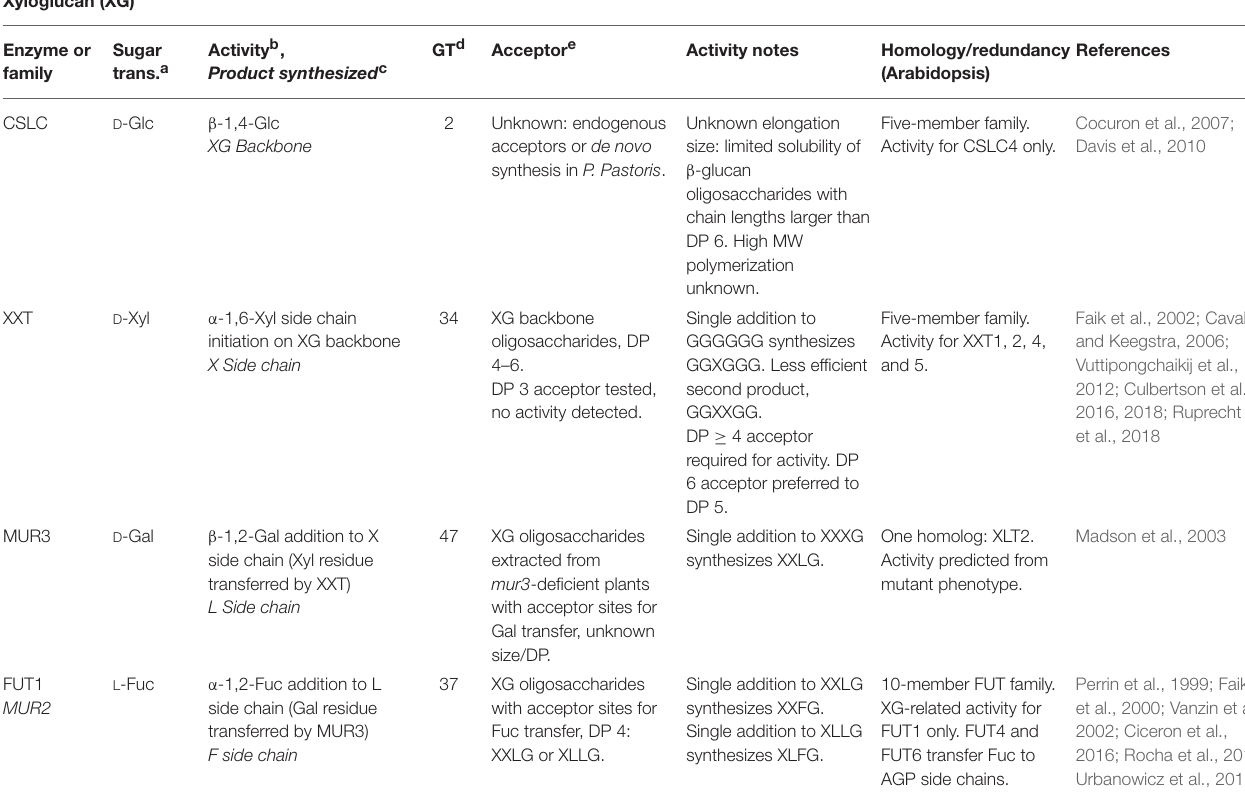
TABLE 1 | Xyloglucan biosynthetic GTs of known function determined by heterologous expression. Xyloglucan